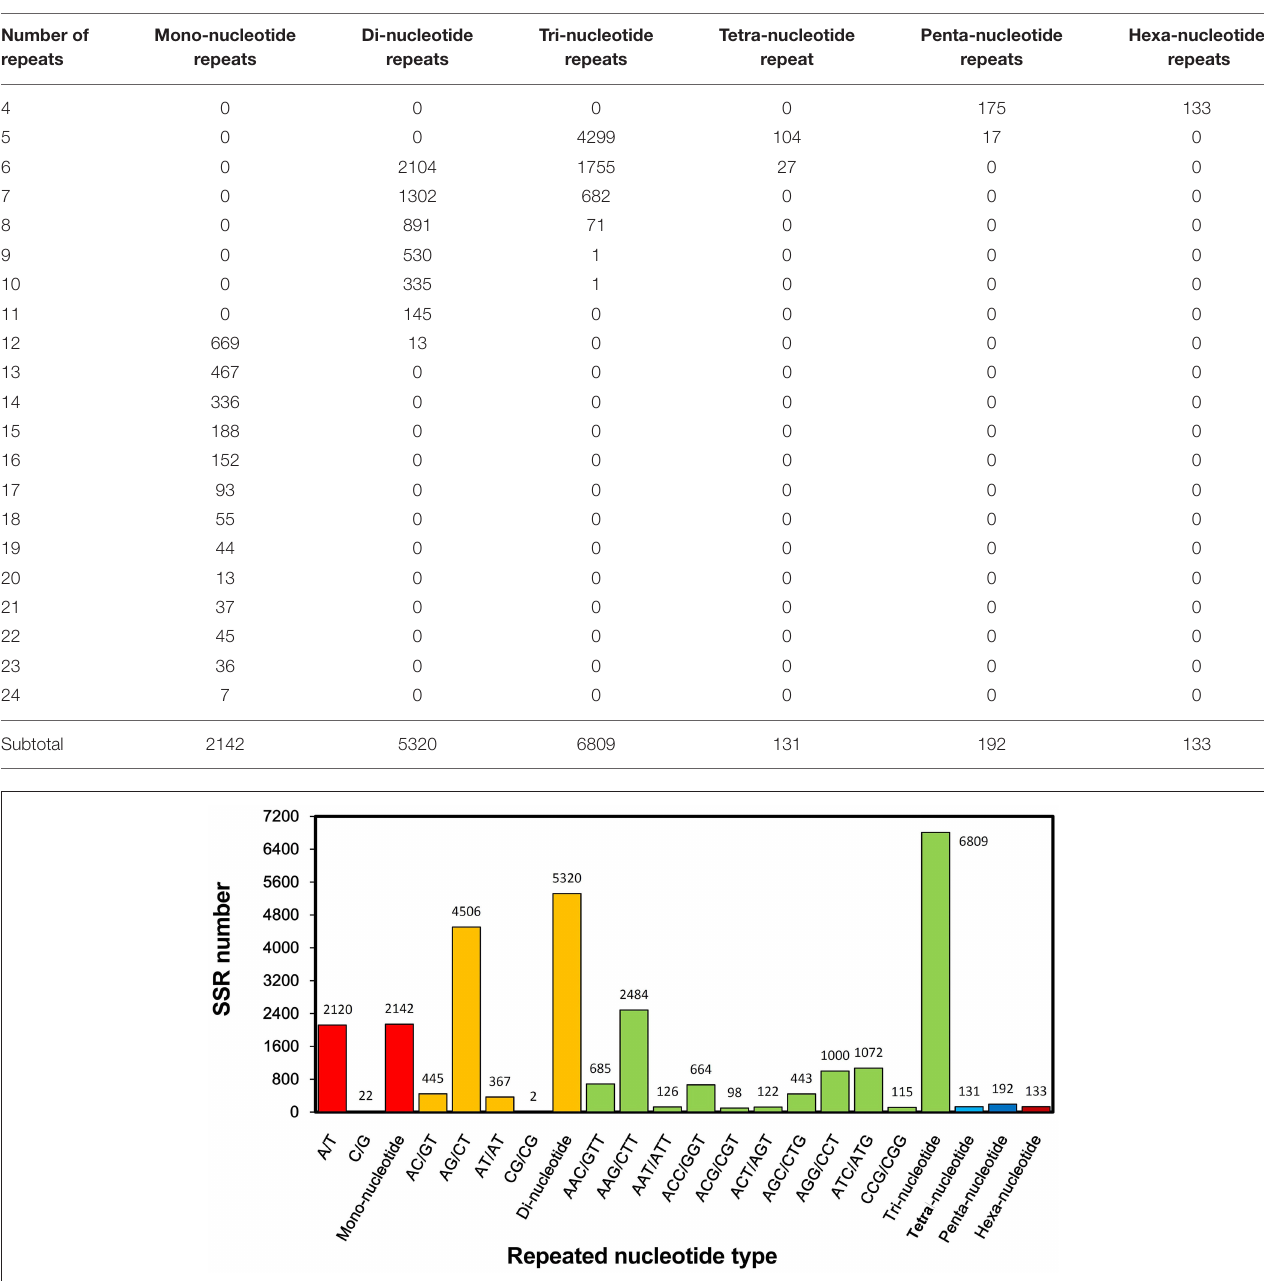
TABLE 2 | Statistics of simple sequence repeat types.